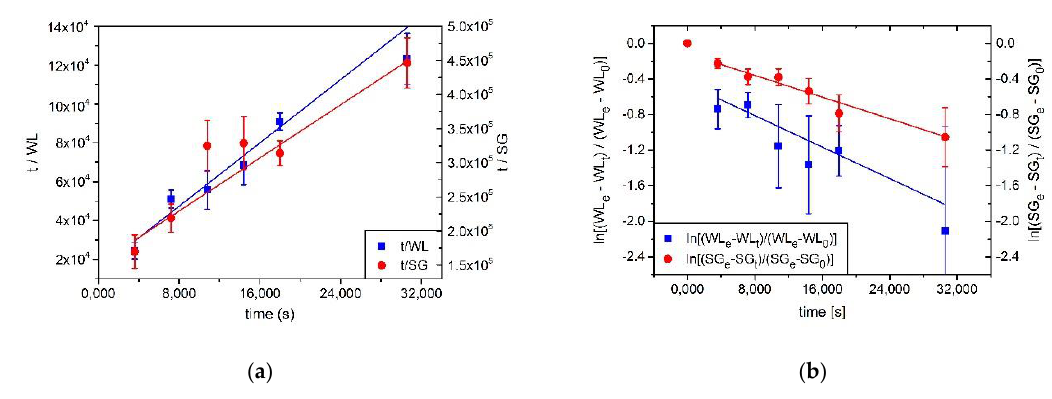
(cid:16) (cid:17) WL e − WL t WL e − WL 0